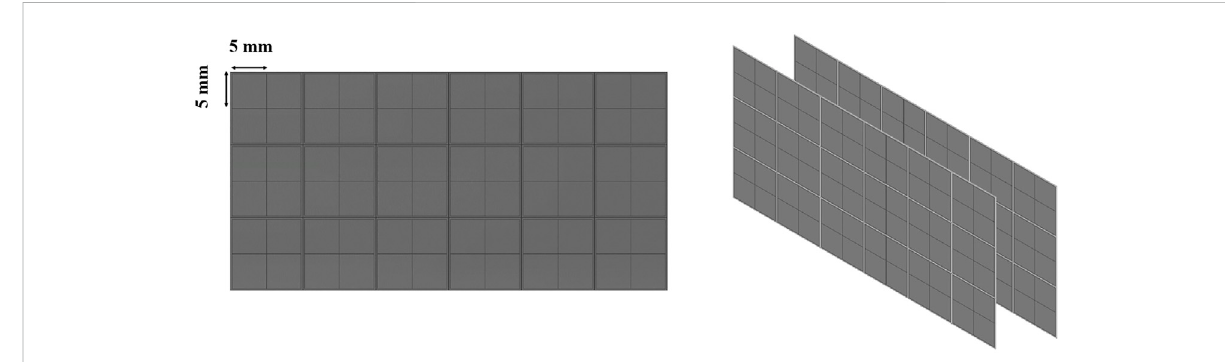
FIGURE 3 Scheme of the SiC detection system for the diagnostics and tagging devices of the FRAISE facility: frontal (left) and side (right) views.